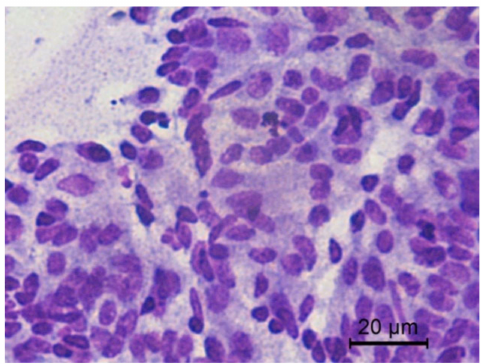
Figure 3. Jenny’s endometrial cytology collected by CB in estrus. Endometrial epithelial columnar cells. Dense and granular background is present. Modified Wright’s stain 400 × .